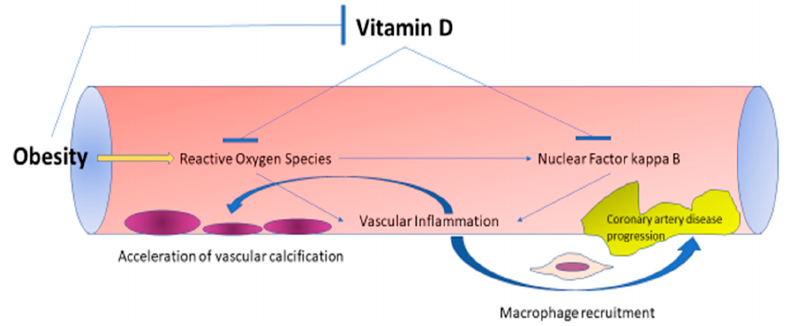
Figure 1. Proposed effects of vitamin D on obesity-related atherosclerotic progression. Vitamin D prevents further macrophage recruitment in atherosclerotic lesions and decreases vascular inflammation through inhibition of nuclear factor kappa B and decoying of reactive oxygen species. Obesity alleviates the beneficial effects of vitamin D on the vasculature by decreasing vitamin D bioavailability and augmenting the production of reactive oxygen species.